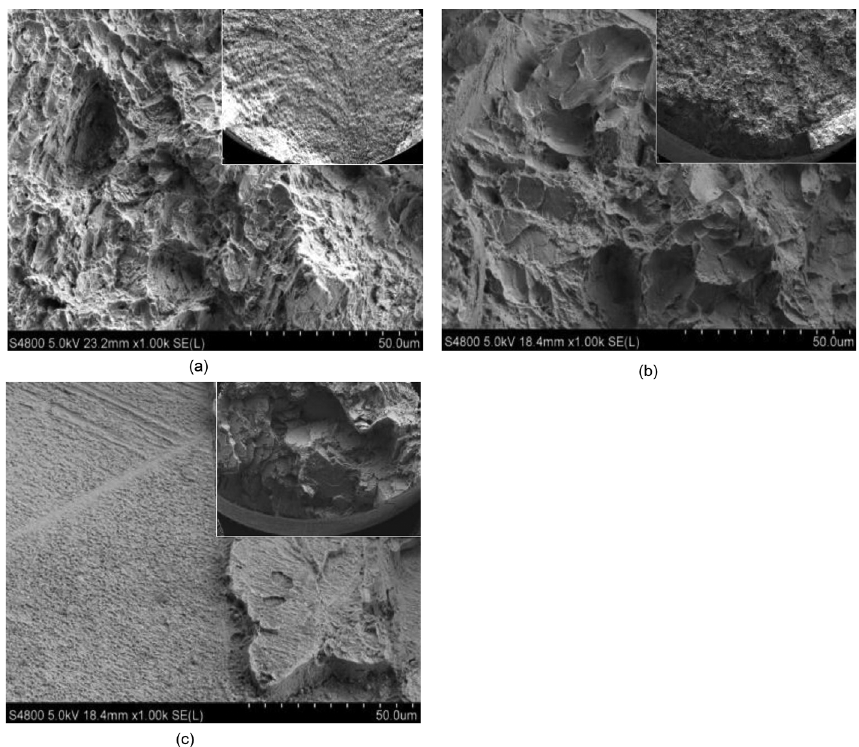
Figure 10: Fracture morphology of Ti-7Cu alloy with forging ratio of 60% in different temperature (a) 1000 ℃ , (b) 1050 ℃ , (c) 1100 ℃